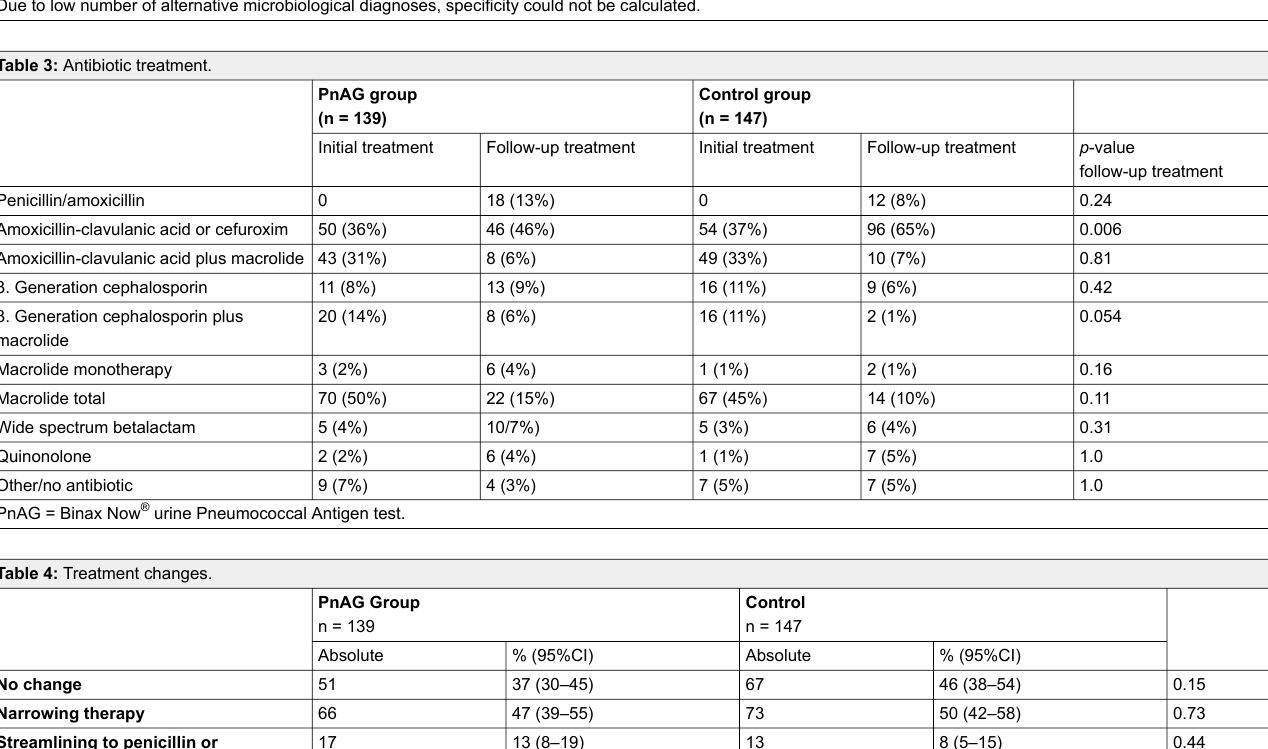
Table 3: Antibiotic treatment.